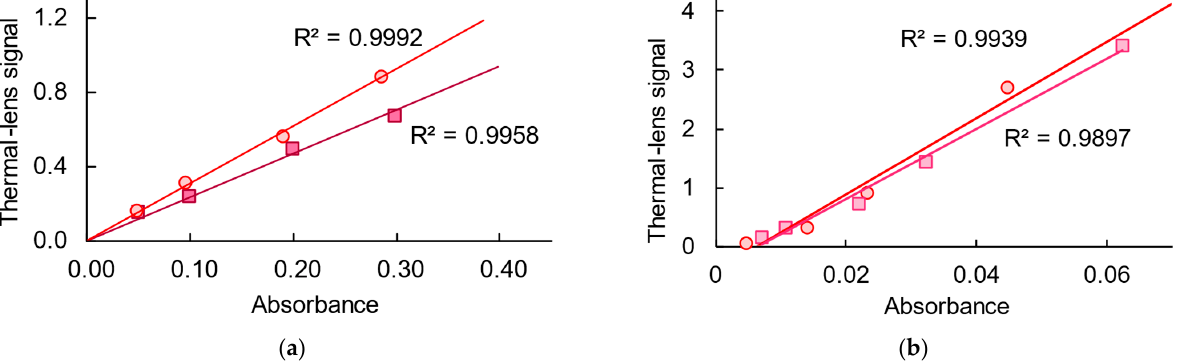
Figure 4. Thermal-lens signal vs. absorbance, Equation (10), ( a ) for ferroin (red curve, circles) and MetHbCN (dark red curve, squares) in 0.1 M PBS and ( b ) for ferroin (red curve, circles) and myoglobin (pink curve, squares) in 0.1 M PBS. Setup, TLS-60; excitation wavelength, 514.5 nm; excitation power, 25